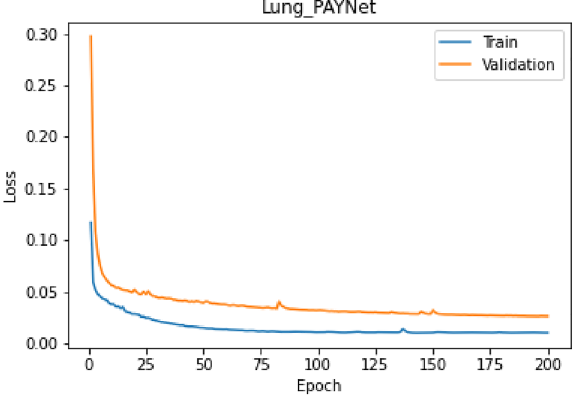
Figure 6. Training and Validation Losses of proposed Lung_PAYNet.